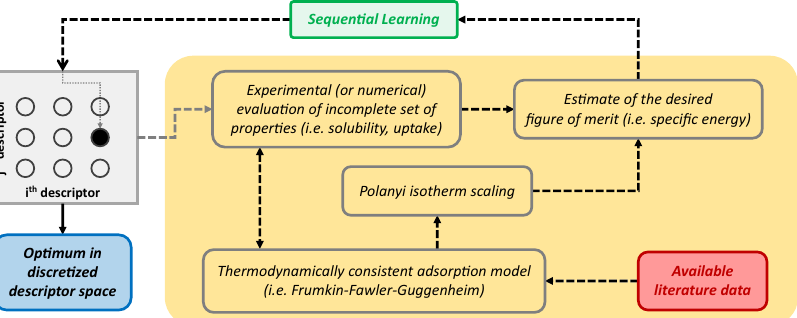
Fig. 5 Suggested procedure for estimating the speci fi c energy of hypothetical MOF-water working pairs when only an incomplete knowledge of the isosteric fi eld is experimentally or numerically accessible. By the knowledge of Henry coef fi cient for H 2 O at a certain temperature from literature data, an isotherm is obtained by Frumkin – Fawler – Guggenheim; the Polanyi potential is used for scaling to different temperatures. When two isotherms of interest are identi fi ed, upon the de fi nition of the necessary environmental conditions and the use of an incomplete set of properties (e.g., solubility, uptake), the corresponding speci fi c stored energy can be computed. SL algorithms can be employed for optimizing the desired fi gure of merit/properties in a discretized descriptor